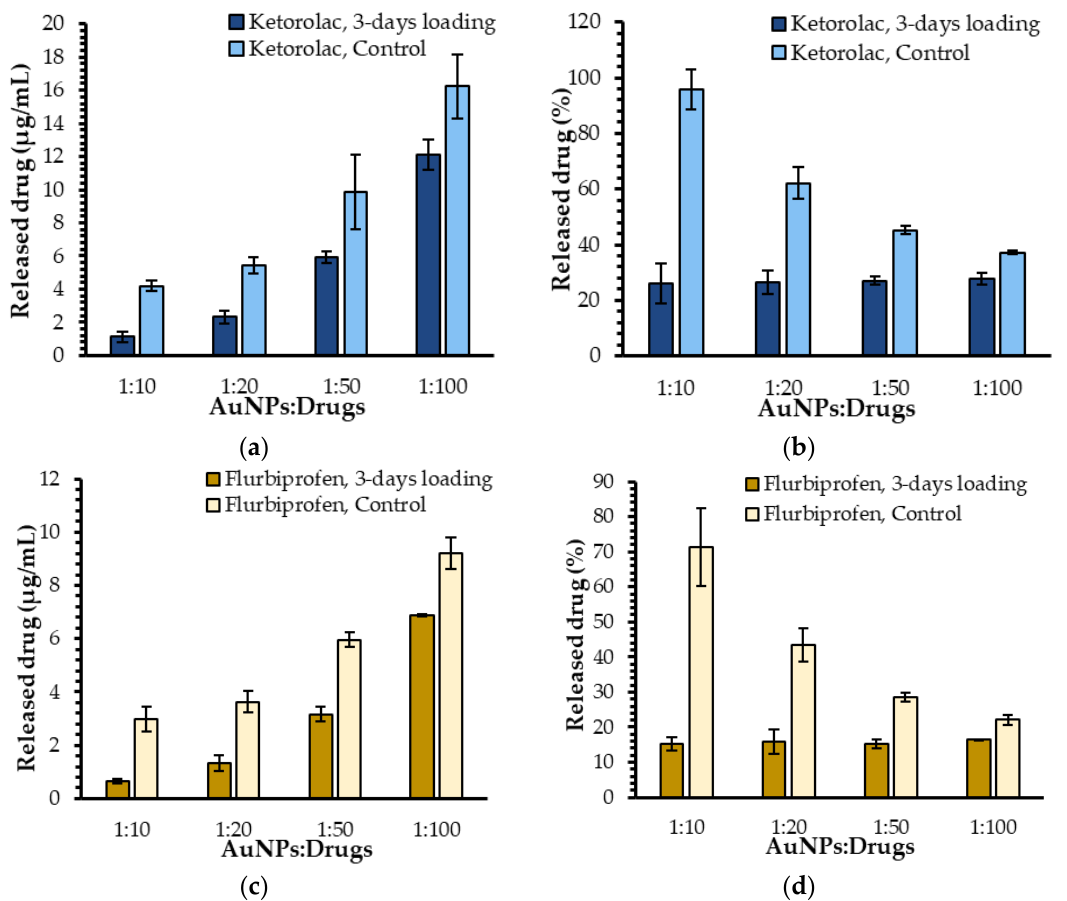
Figure 4. ( a ) Drug release concentrations for ketorolac with and without AuNPs; ( b ) the associated ketorolac release percentages; ( c ) drug release concentrations for flurbiprofen with and without AuNPs; ( d ) the associated flurbiprofen released percentages.